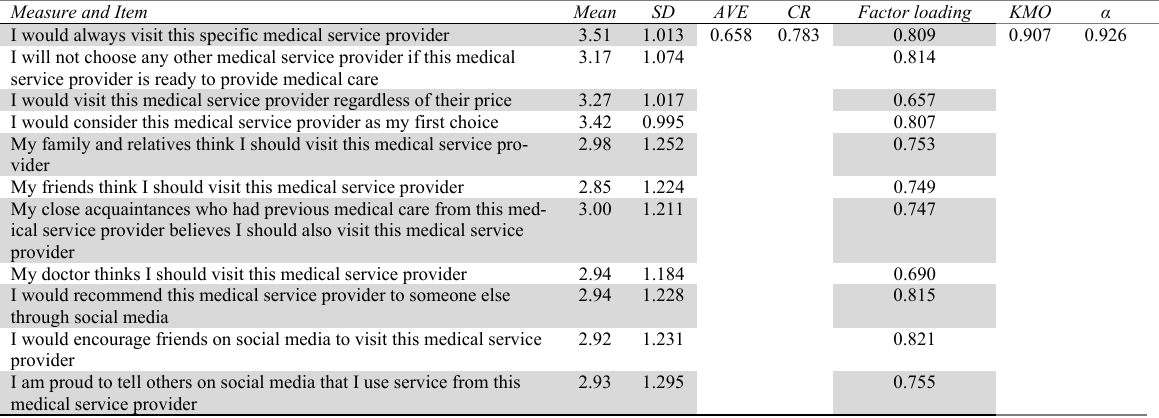
Behavioral Intentions Scores